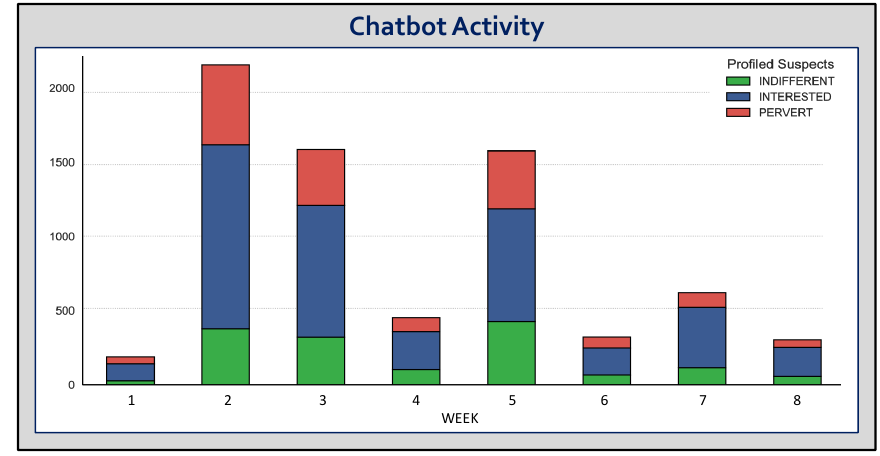
Figure 7. Chatbot